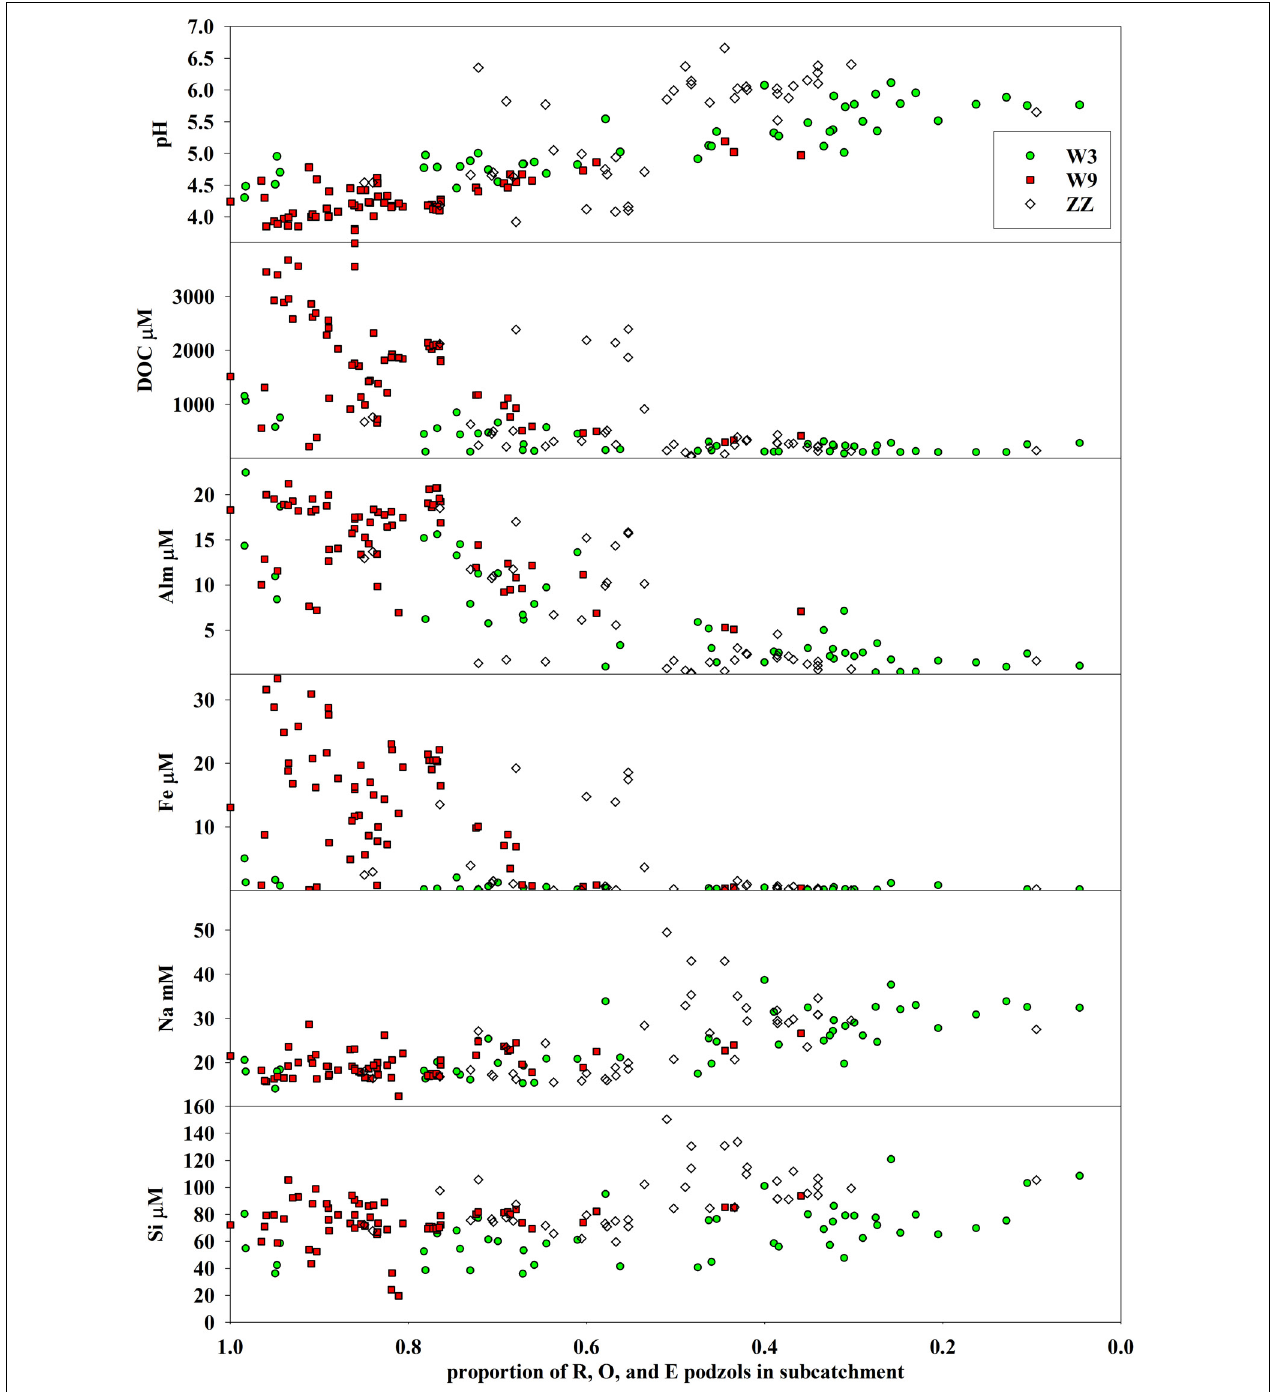
FIGURE 9 | Variation in surface water pH and concentrations of dissolved organic carbon (DOC), monomeric aluminum (Al m ), iron (Fe), sodium (Na), and silicon (Si) versus proportion of each sampling site’s contributing subcatchment in rock outcrops, O-horizon on shallow bedrock, and E-podzols (R–O–E). The proportion of R–O–E soils decreases toward the right, and generally moving downstream along any given tributary.